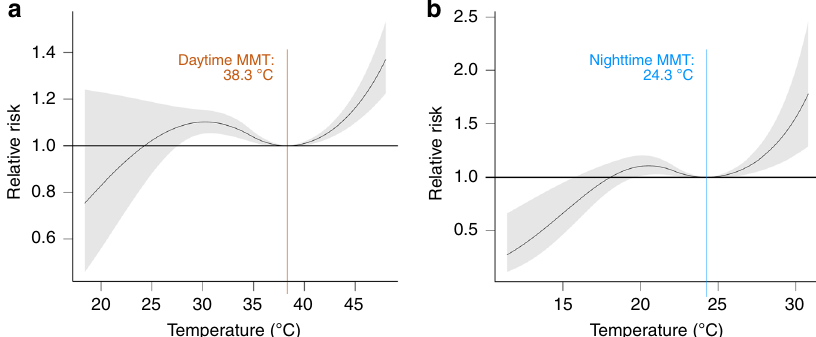
Fig. 1 Relative risk (RR) curves derived in this study. The RR curves show the minimum mortality temperature (MMT) thresholds for a daytime and b nighttime. The MMT thresholds were used in the preparation of a heat hazard layer. MMT refers to the temperature at which the probability of dying is lowest. RR refers to the probability of a person dying when exposed to non-optimum temperature as a ratio of the probability of a person dying when exposed to optimum temperature (i.e., the MMT). See Methods